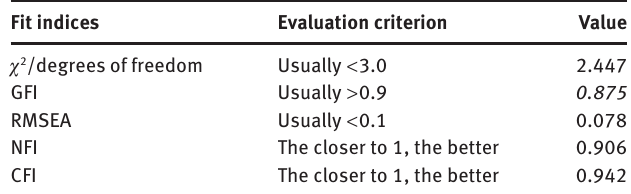
Table 3. Adjusted Model Fitting Evaluation.